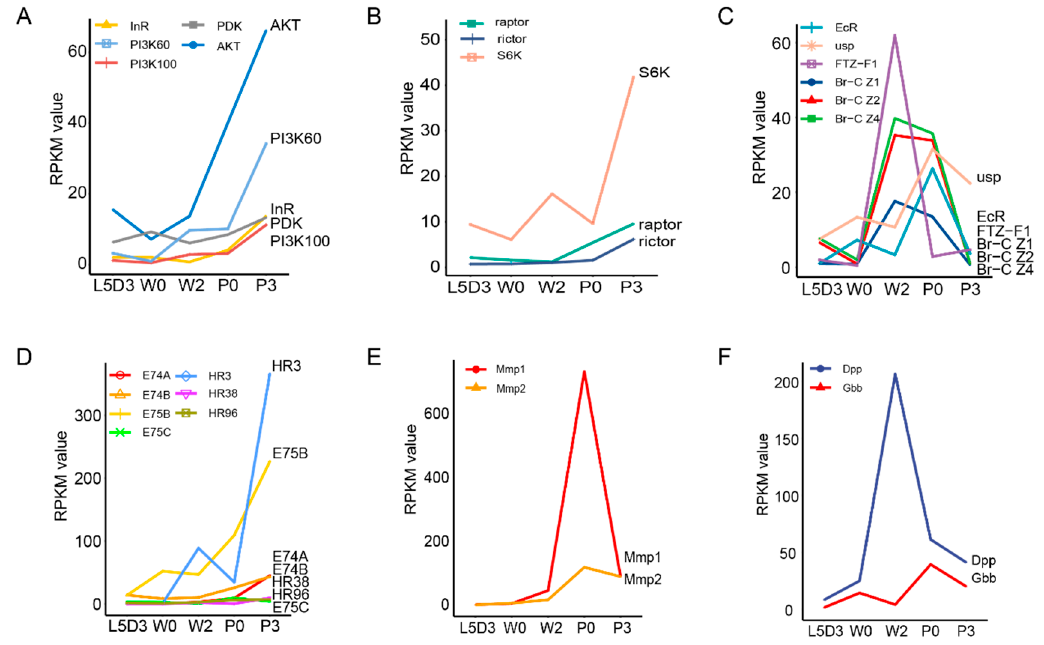
Figure 6. Expression changes of DEGs involved in several signaling pathways related to metabolic activity and organ remodeling. ( A , B ) DEGs involved in the insulin/insulin-like growth factor signaling (IIS) and target of rapamycin (TOR) signaling pathways, which are related to metabolic activity. ( C–F ): ( C , D ) DEGs involved in the ecdysone signaling pathway, ( E ) matrix metalloproteinases, and ( F ) the bone morphogenetic protein (BMP) signaling pathway, which are related to organ remodeling. AKT, serine/threonine protein kinase; InR, insulin receptor; PDK, pyruvate dehydrogenase kinase; usp, ultraspiracle protein; EcR, ecdysone receptor; FTZ-F1, fushi tarazu transcription factor 1; HR, hormone receptor; Mmp, matrix metalloproteinase; Dpp, decapentaplegic; Gbb, protein 60A; L5D3, the third day of the last larval instar; W0, just wandering; W2, the second day during wandering; P0, just pupation; P3, the third day after pupation.